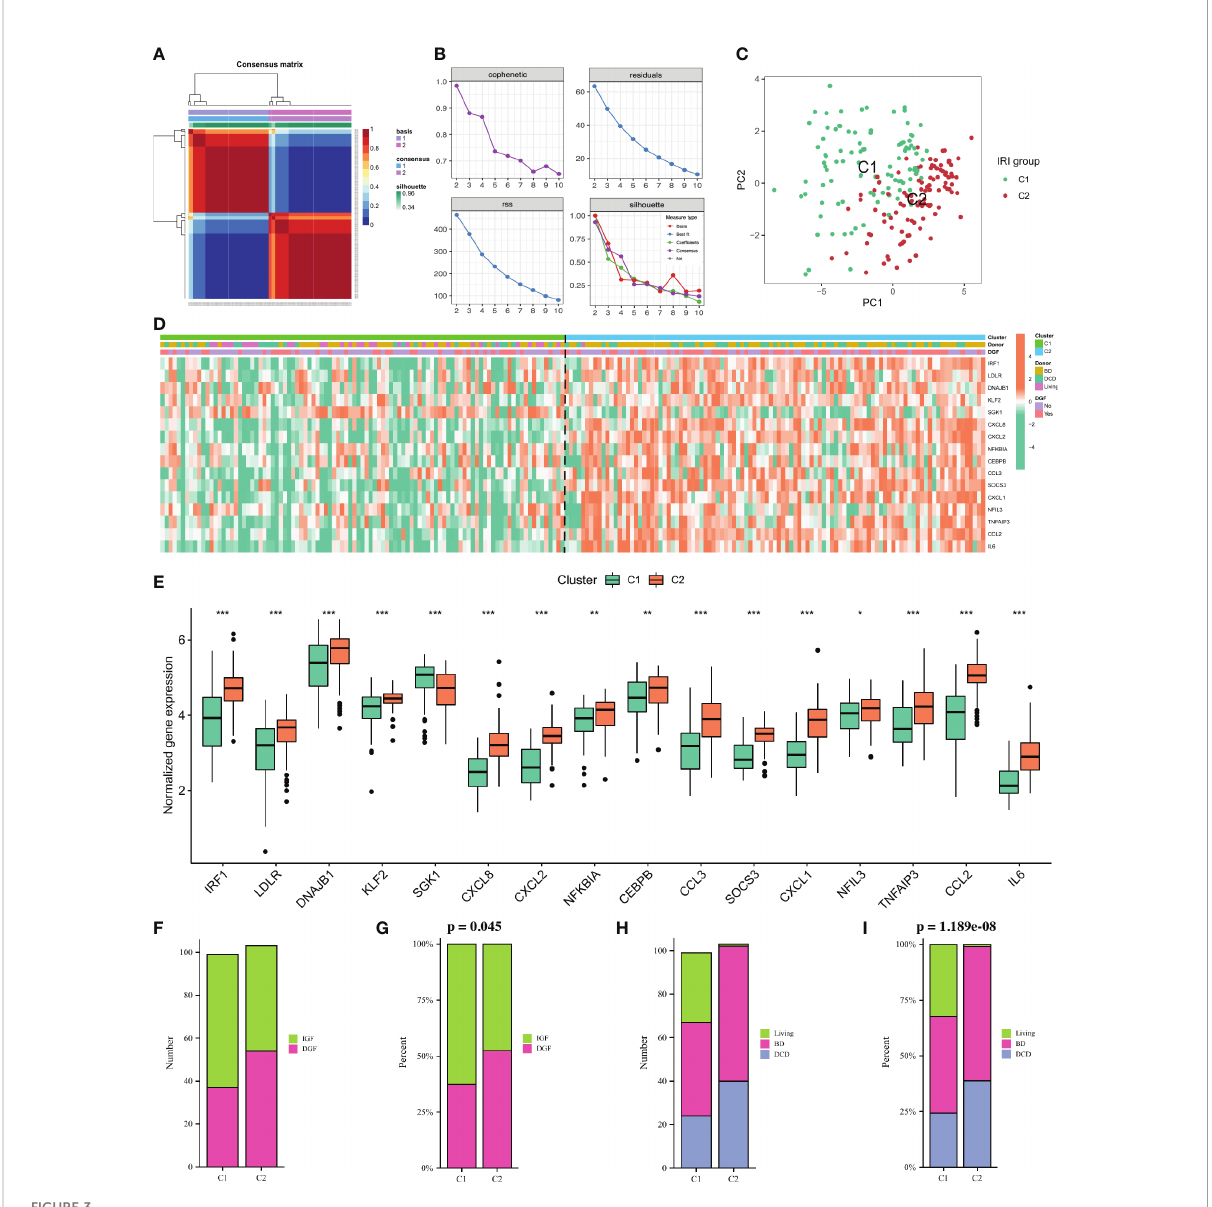
FIGURE 3 Non-negative matrix factorization (NMF) analysis for the IRI samples. (A) Consensus map of NMF clustering when k = 2. (B) Distribution of cophenetic, residuals, RSS and silhouette with a rank of 2 – 10. (C) A PCA plot of the expression pro fi le of DE-NRGs between two clusters. (D) : Heatmap showing the expression landscape of DE-NRGs and the clinical characteristics of the two clusters. (E) : Box plot showing the expression of 16 DE-NRGs between the two clusters. (F, G) : Histogram comparing the differences in donor between the two clusters. (H, I) Histogram comparing the differences in the occurrence of DGF between the two clusters. IRI, ischemia reperfusion injury; RSS, residual sum of squares; PCA, principal component analysis; DE- NRGs, differentially expressed NET-related genes; DGF, delayed graft function. *P < 0.05, **P < 0.01, ***P <